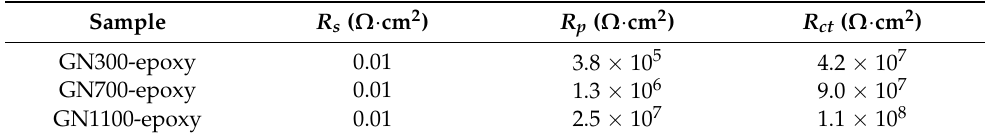
Table 4. Fitted equivalent circuit parameters of EIS for coatings filled with 0.05 wt.% of GN300, GN700 and GN1100 immersed in 3.5 wt.% NaCl solution.